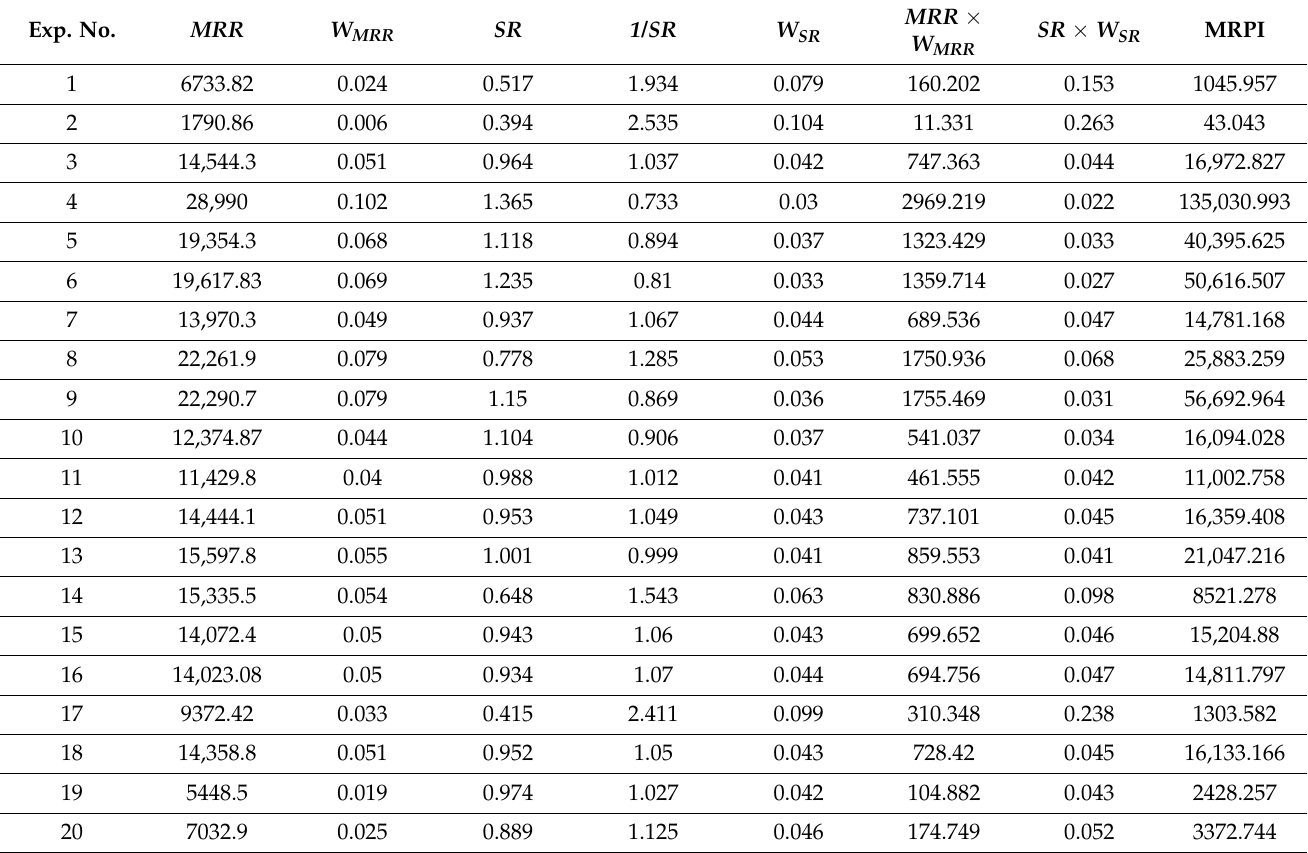
Table 6. Results of DEAR